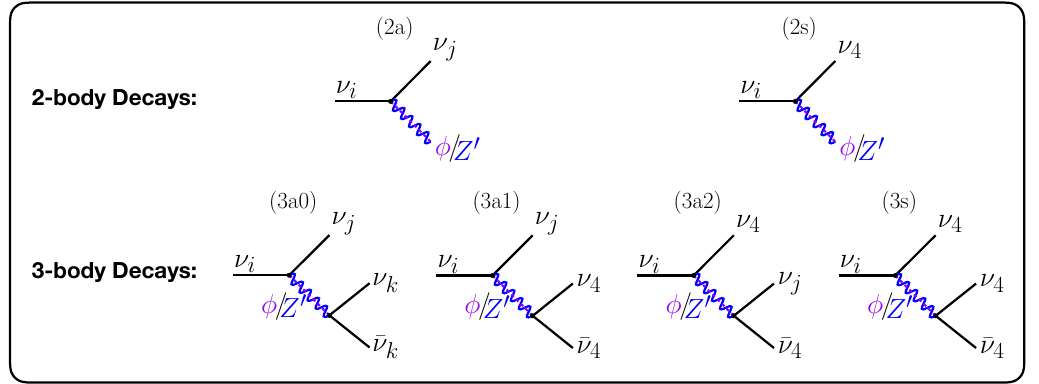
Figure 1 . Possible diagrams describing invisible neutrino decays of the mainly active neutrino mass eigenstate ν i . Here the indices i, j, k take values from 1 to 3 . ν 4 refers to a mainly sterile mass eigenstate with small mixing with the active neutrinos ν α . φ and Z 0 are neutrinophilic scalars and vector bosons,